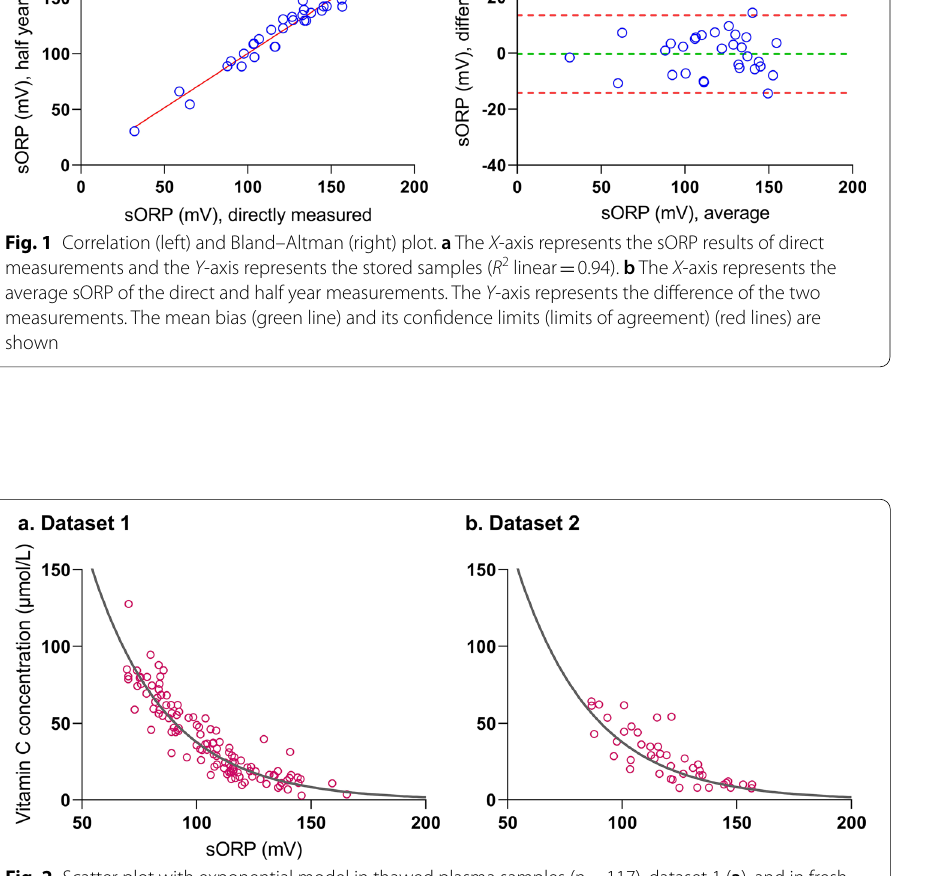
117), dataset 1 ( a ), and in fresh =